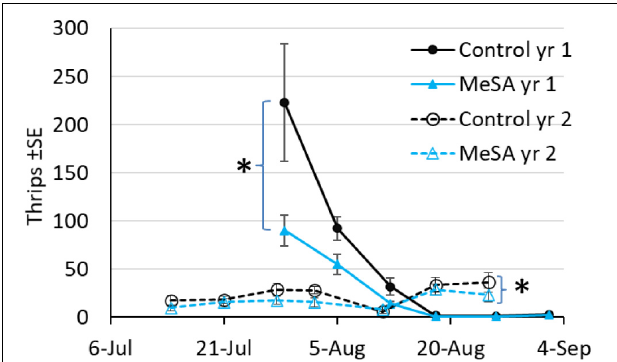
FIGURE 2 | Mean number of thrips on sticky cards during a 2 year red maple field study. Asterisk indicates a difference between treatments over the season, GLMM p <